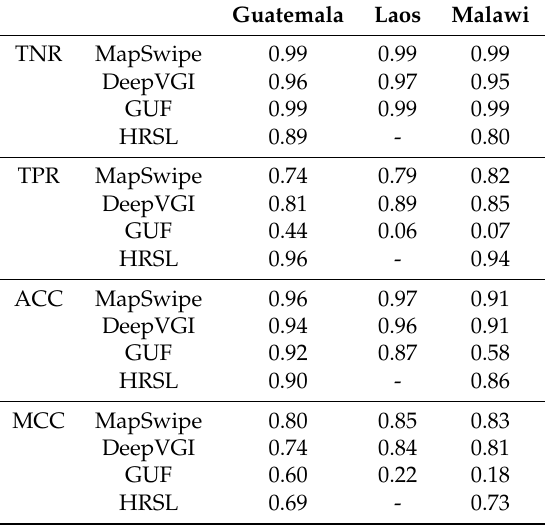
Table 2. Performance of different methods to generate human settlement data